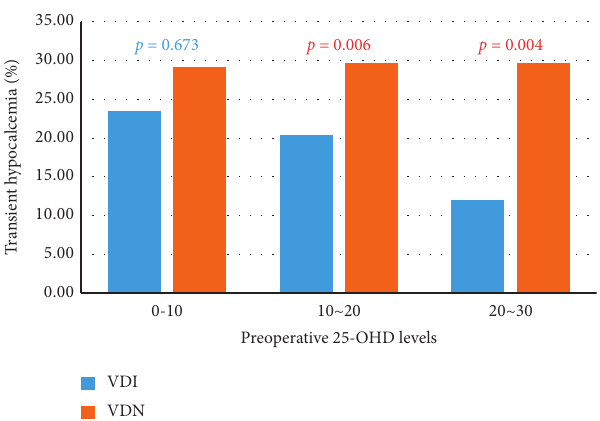
Figure 2: Comparison of incidence of postoperative transient hy- pocalcemia between vitamin D3 injection (VDI) and vitamin D3 noninjection (VDN) groups according to preoperative 25-hydrox- yvitamin D (25-OHD)